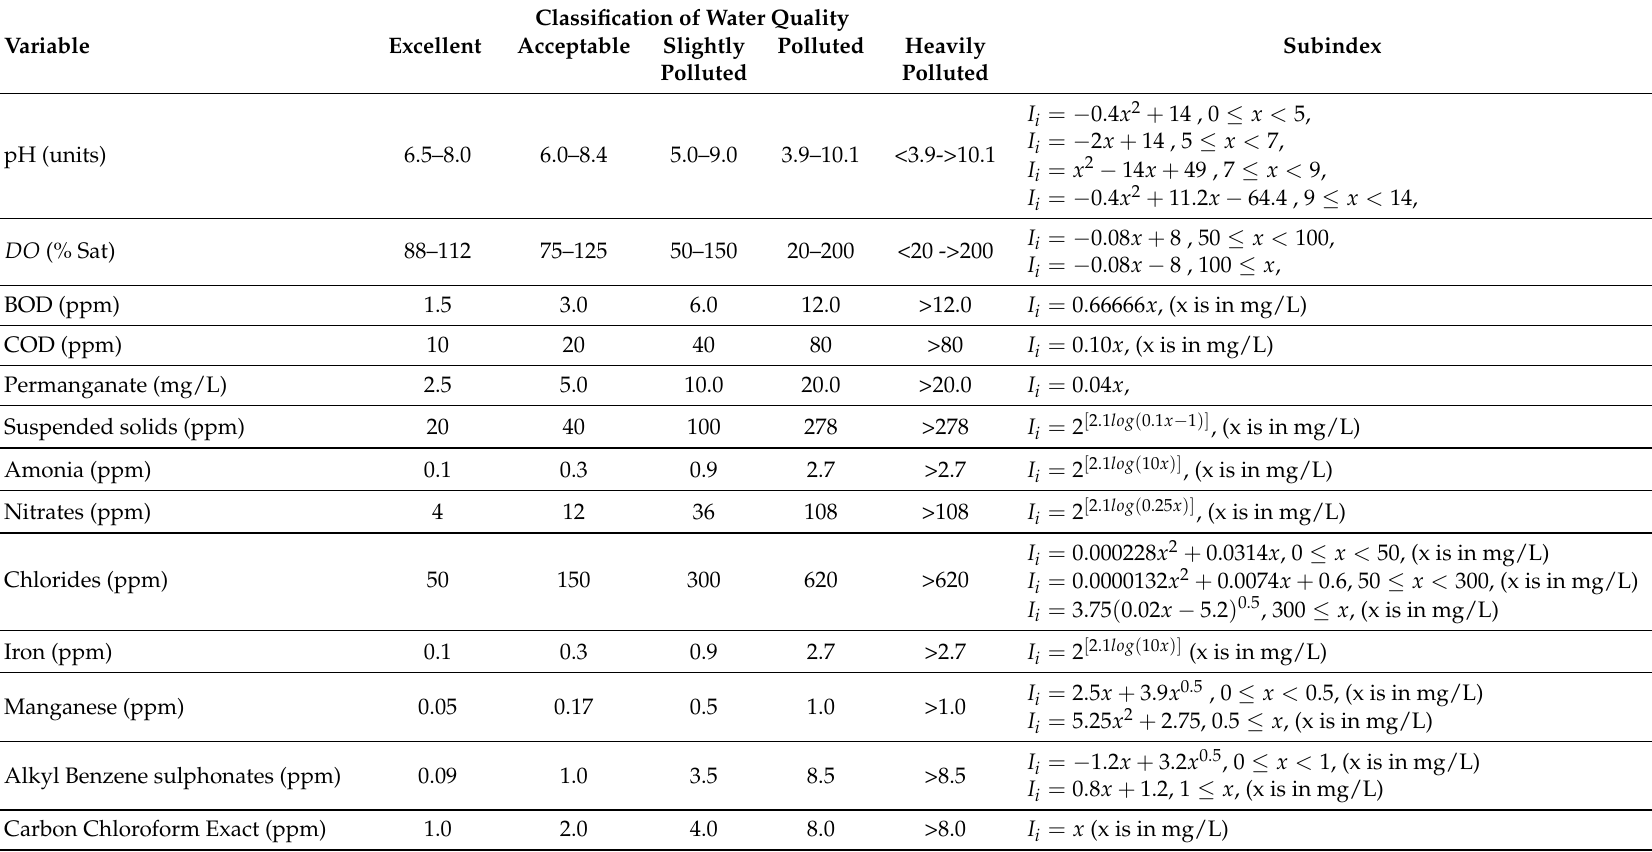
Table A2. Classification of water quality and subindex functions for the Development of Prati’s